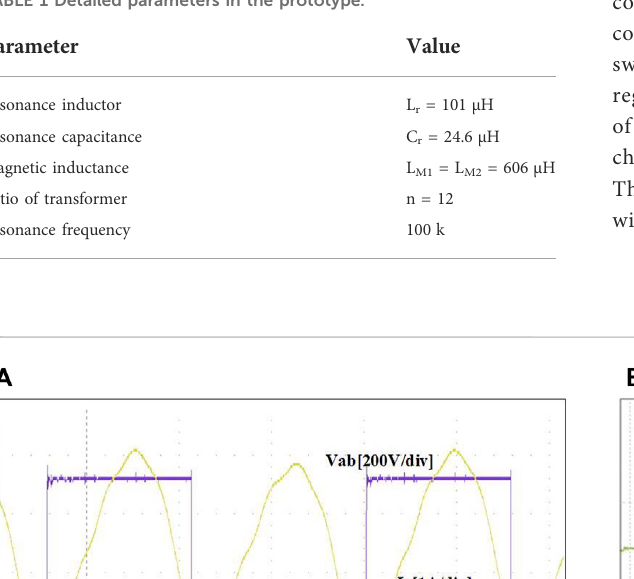
TABLE 1 Detailed parameters in the prototype.